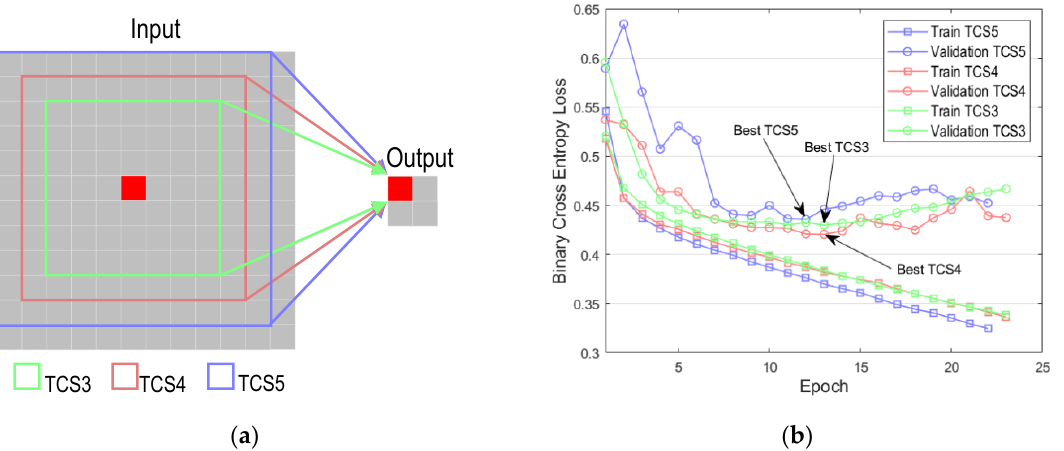
Figure 19. ( a ) The input and output sketch map of different total convolution size (TCS) for each pixel; ( b ) Binary cross entropy loss vs epoch curve of different TCS, the black arrow showed the best model position as we used an early stop with patience = 10 on the TensorFlow software.